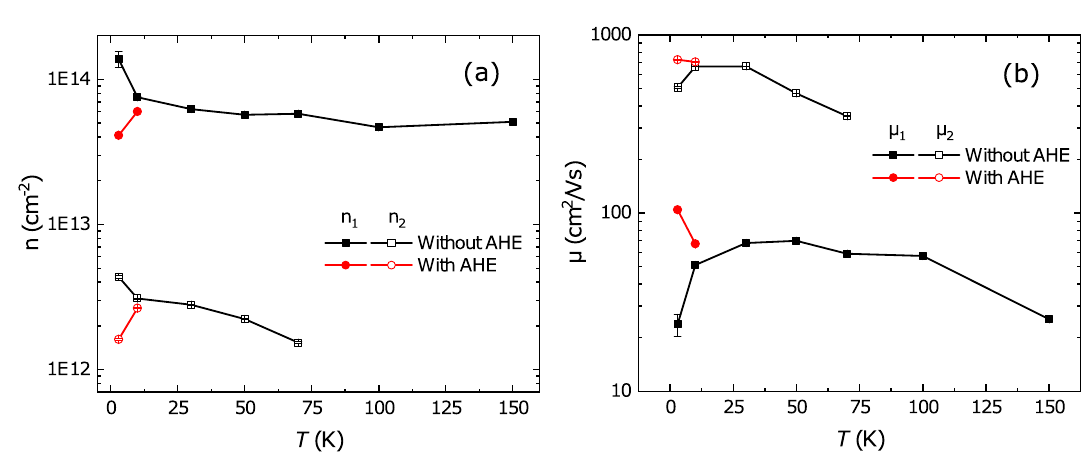
Figure 4. (a) Carrier concentration n and (b) mobility µ versus temperature for the LGAO/GLTAO/STO sample before applying the gate voltage. The black squares follow from the analysis without taking an AHE contribution into account, the red circles are the result of incorporating an AHE contribution as described in the